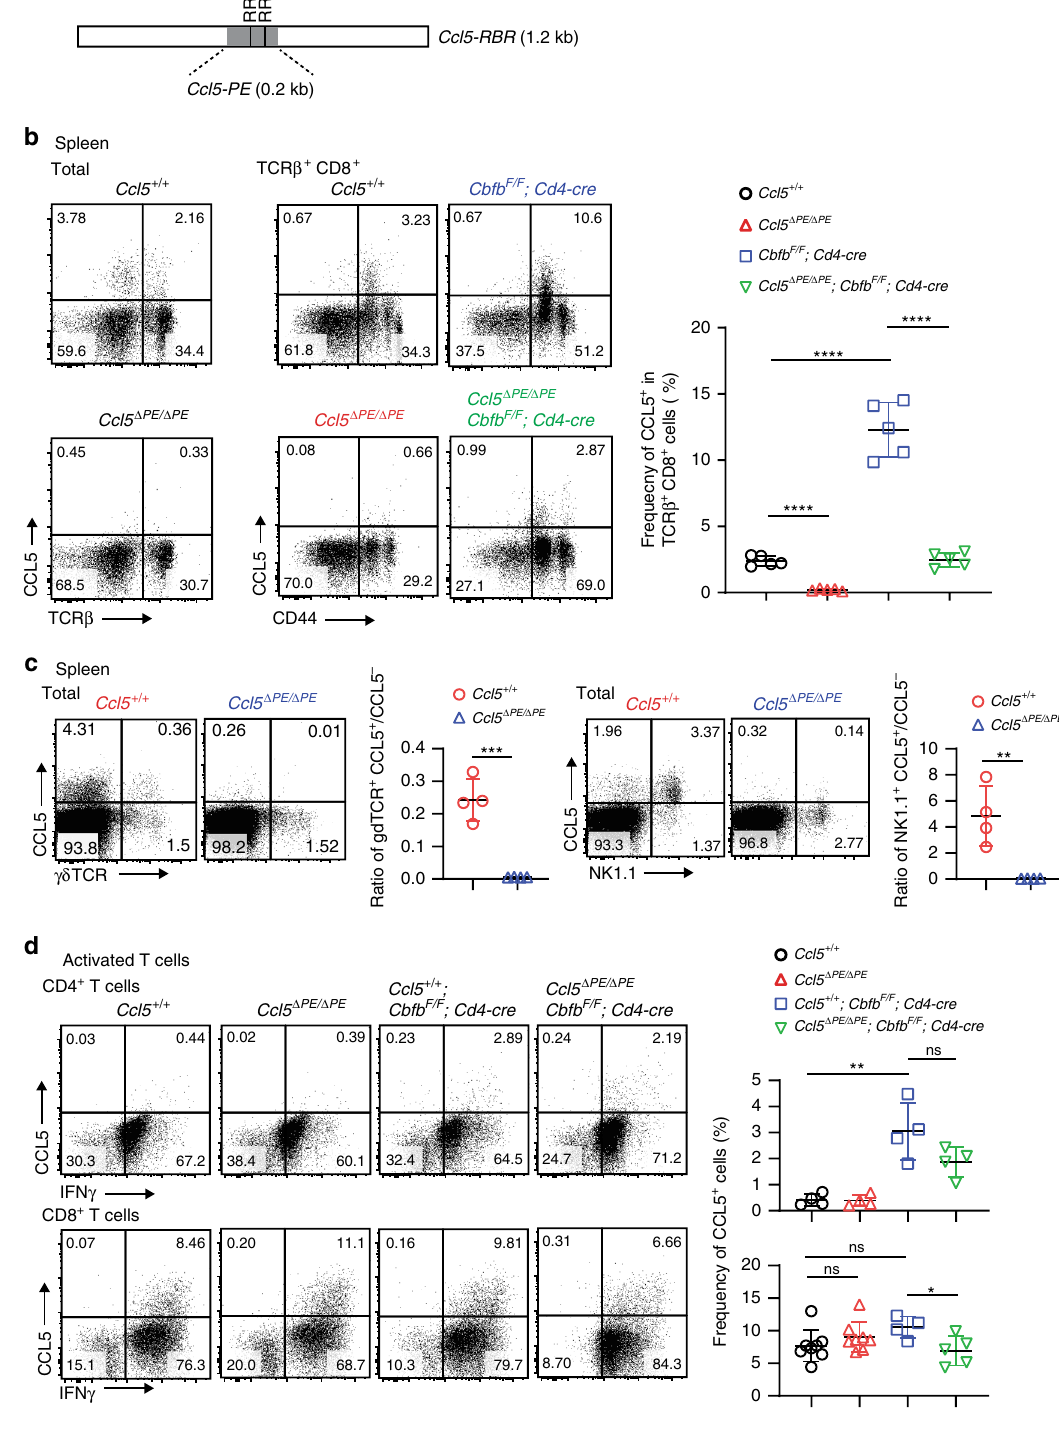
(AP) in a region near the Ccl5 promoter and two primers (S1